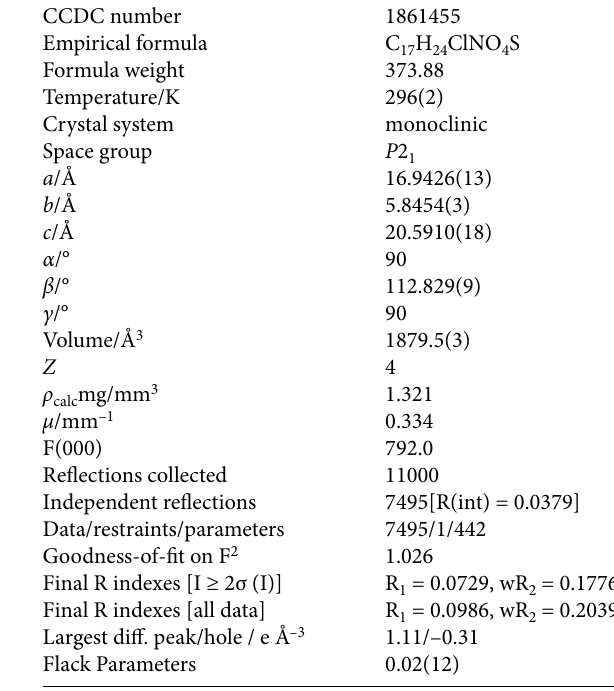
Table 1. Crystal data and structure refinement for